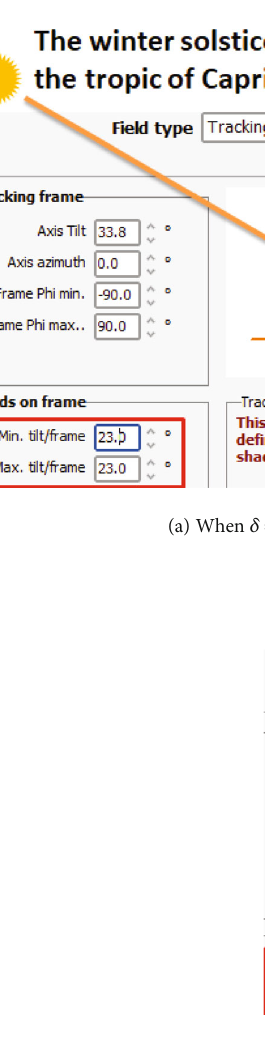
Figure 21: The tilt of the panel in relation to the solar tilt in The solar collector: the three analogue signals recovered